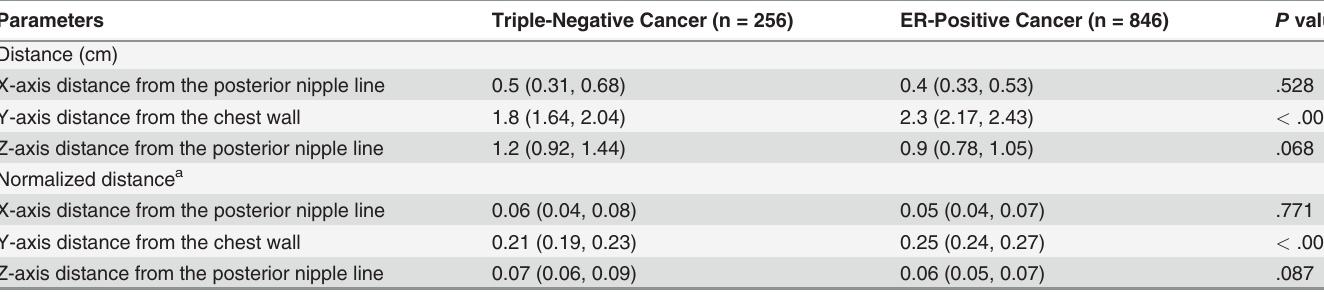
Table 3. Location of Tumors in 3D